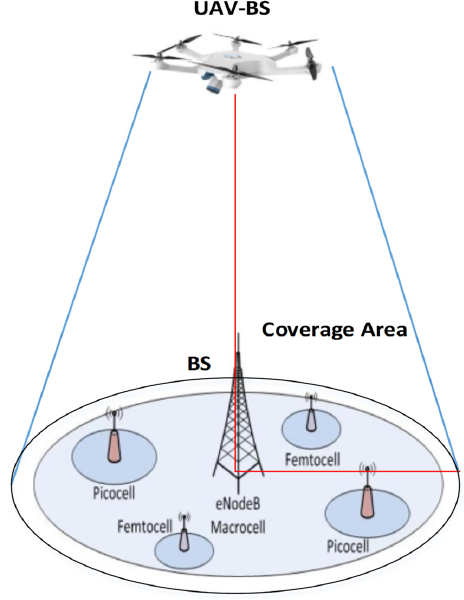
Figure 1. UAV-BS coverage area .